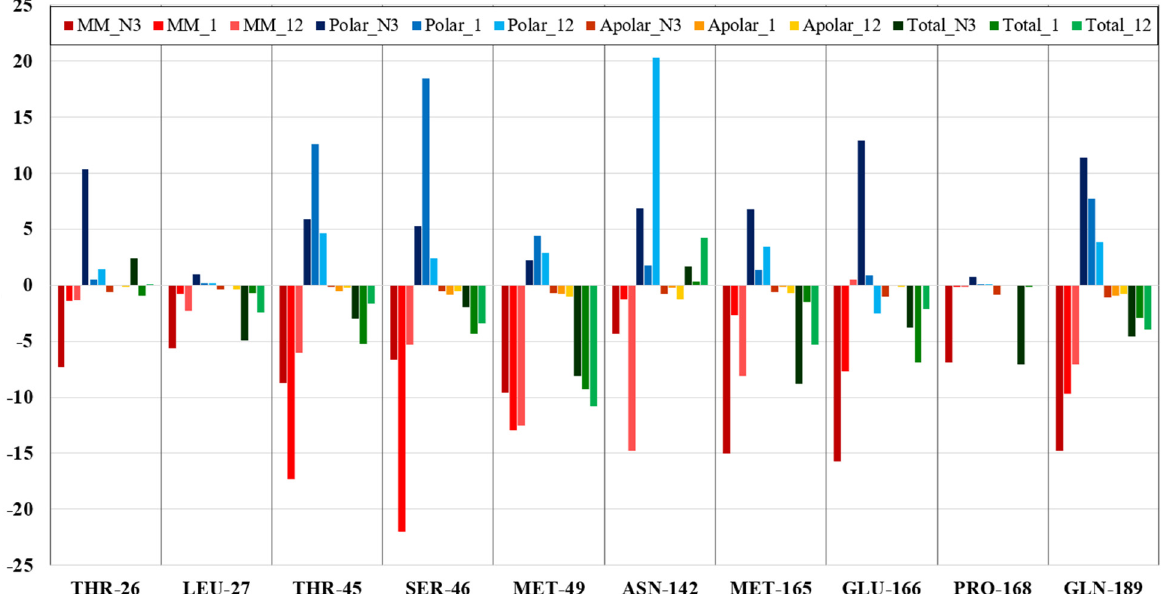
Figure 9. Energy contribution (kJ/mol) of the common interacting amino acid residues of the SARS-CoV-2 3CL protease for compounds 1 and 12 and co-crystallized ligand (N3).